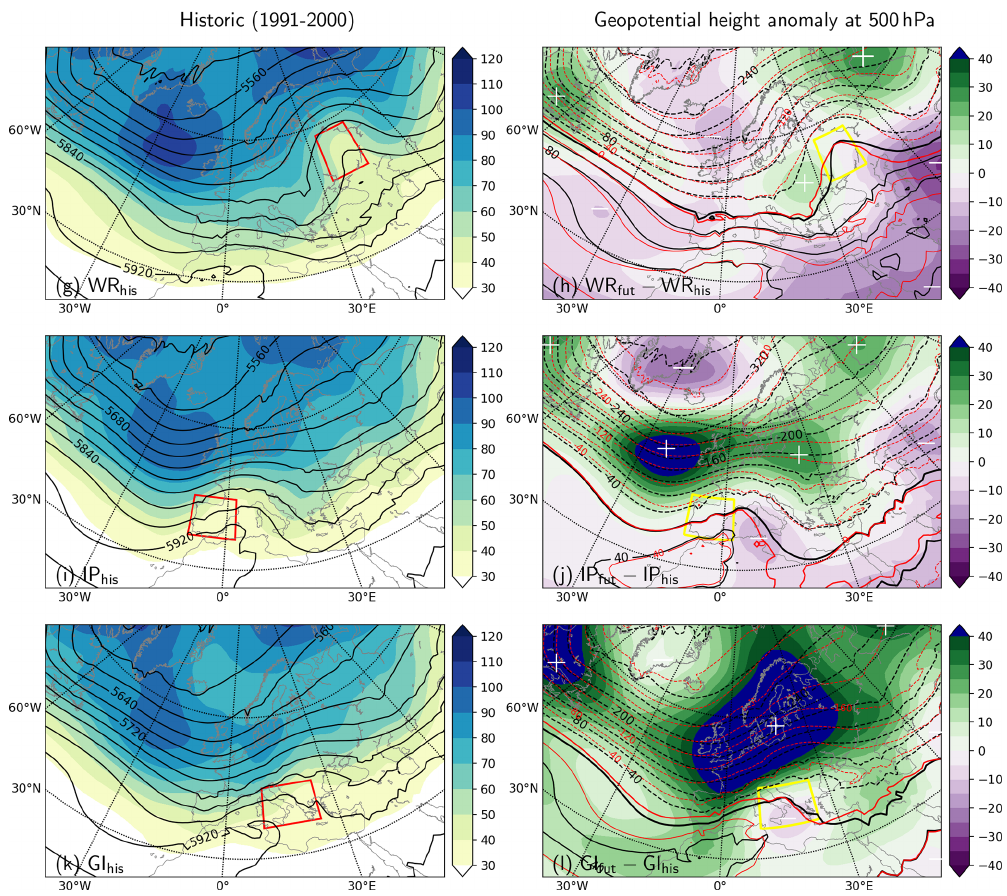
Figure 5. As in Fig. 4 but for (g, h) Western Russia (WR), (i, j) the Iberian Peninsula (IB) and (k, l) Greece and Italy